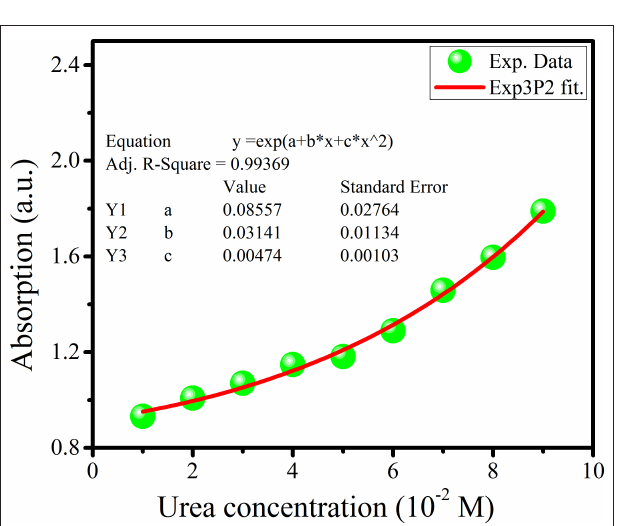
FIGURE 9 | Stability of developed